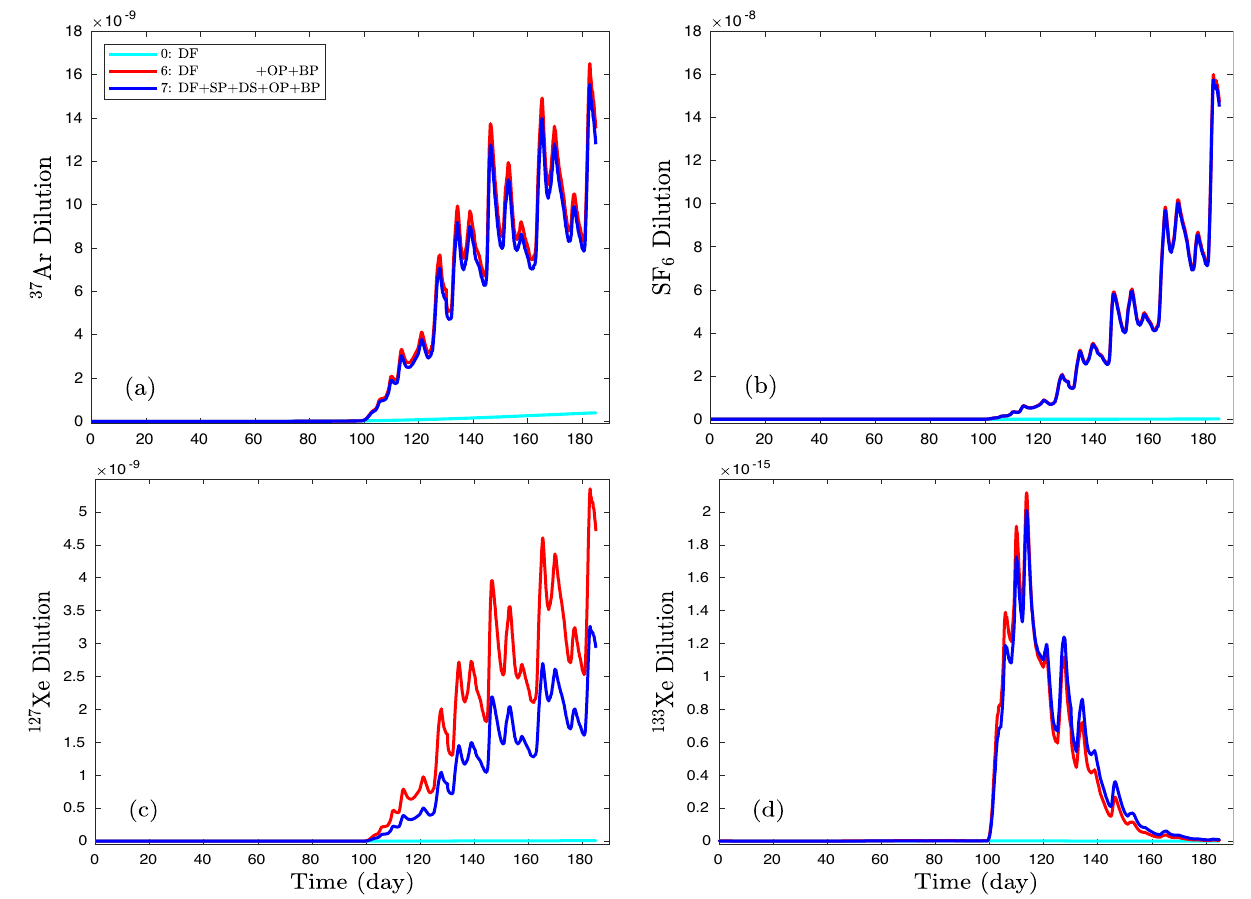
37 127 Figure 7. Using deterministic models, concentration profiles are plotted for ( a ) Ar, ( b ) SF 6 , ( c ) Xe, and 133 ( d ) Xe at the depth of 0.5 m. Although combined delaying or driving process models (#5, 6) are compared with reference models (#0 and 7), model #5 results are not plotted due to its negligible Models #5 and 6 demonstrate the combined effect of delaying processes (sorption and dissolution) and of driving forces (overpressure and barometric pumping), respectively. Figure 7 shows the concentration profiles of models #0, 6, and 7. The minor difference between the base model (#0) and the model of double retarding effect (sorption and dissolution, #5) is not plotted. The offset between models #6 and 7 is evaluated as the effect of delaying processes (SP, DS) while the difference between models #6 and 0 is calculated as the effect of driving forces (OP, BP). The concentration profile of model #0 is the contribution of diffusion. The roles of the basic (diffusion), delaying, and driving processes are demonstrated as shown in Fig. 8. A minor role of diffusion is observed for 37 Ar in Fig. 8a (yellow). Although the diffusion contribution is plotted on a log scale in the inset of Fig. 8b, it is orders of magnitude lower than that of delaying and driving processes. Figure 6 illustrates how the two driving processes, barometric pumping (red line) and overpressure (black line), can interact in a synergistic manner transporting more gas to the surface (blue line) than either acting independently (see also Harp et al. 56 ). Over pressurization can indeed drive gas to the surface along fractures. However, over pressuring of a cavity, acting alone, will also work with diffusion to drive a gas flowing upward from a region of higher concentration along a fracture as well as through the porous walls of the fracture into the rock matrix causing gradual dilution of the tracer with distance along the fracture. On the other hand, a decrease in barometric pressure, acting alone, is most effective in drawing tracer vertically near the surface. Gases are drawn by the falling pressure most effectively into the vertical fracture from the walls at shallow levels where tracer concentrations tend to be much lower than at deeper levels. However, combining both transport mechanisms tends to offset the impediments to transport of each operating alone. A vertical upward flow due to pressurization carries tracer which is gradually lost into the matrix as the tracer moves upward. Continuing this process loads the matrix with tracer. During falling atmospheric pressure, the pressure front propagates from the surface down the fracture lowering the pressure locally which not only enhances upward flow in the fracture but, more importantly, draws out tracer stored in the fracture walls into the upward flow. This explana- tion is consistent with the observations of time-dependent tracer concentrations obtained during and after the 10-day pressurization period while Freon was injected into the rubblized cavity in the Barnwell site experiment (Fig. 2, 1 ). During pressurization, tracer levels at the surface peaked during periods of falling atmospheric pres- sure. When over pressurization was stopped, Freon concentration peaks gradually, not immediately, fell between